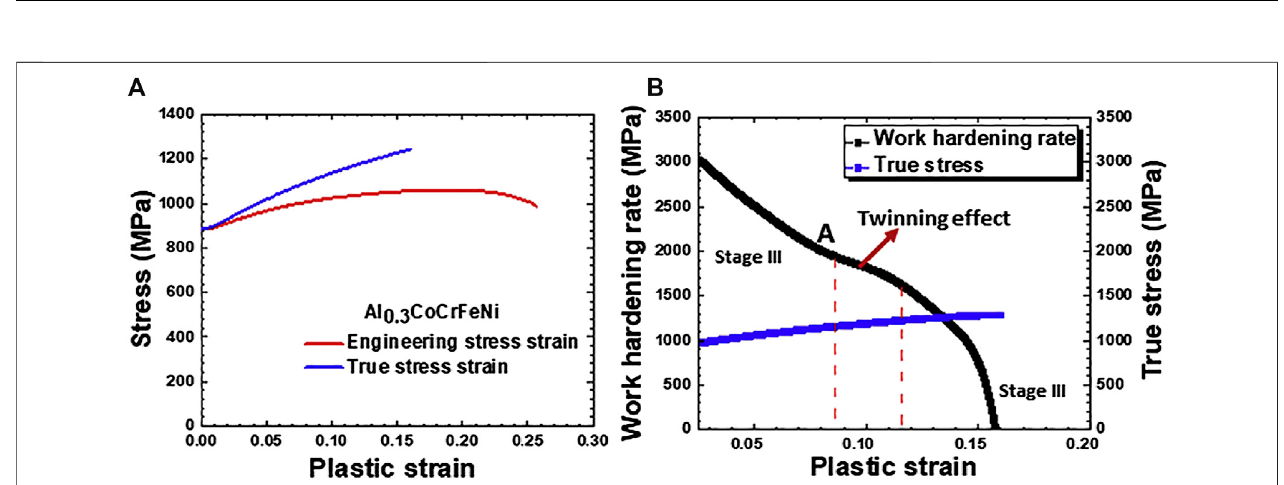
FIGURE 8 | Mechanical properties of UFG Al 0.3 CoCrFeNi (A) Engineering stress-strain and true stress-strain curves, and (B) work hardening rate true strain curve along with true stress-strain denotingthe necking criterion (Liu et al., 2019a).(Reprinted from Scripta Materialia, Vol 158, Liu et al., NFatigue behavior ofultra fi ne grained triplex Al0.3CoCrFeNi high entropy alloy, Pages No.118, Copyright (2019), with permission from Elsevier).